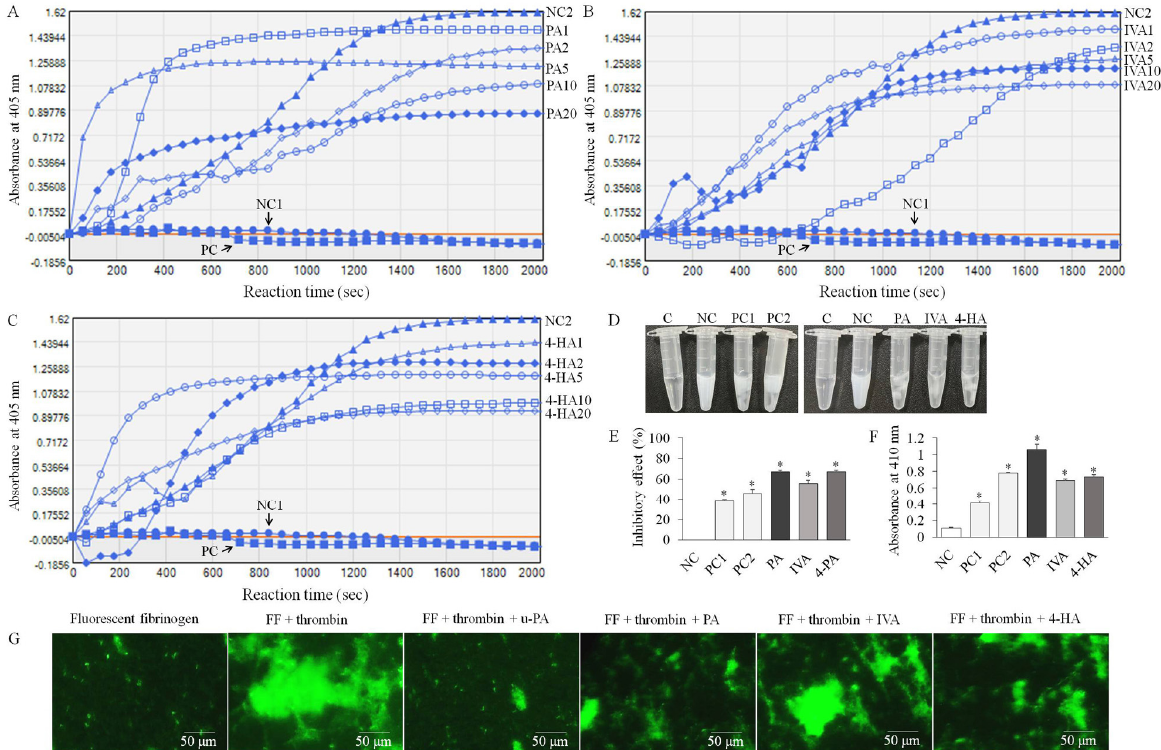
Figure 2. In vitro antithrombotic effects of PA, IVA, and 4-HA. ( A – C ) Turbidity assay. ( D , E ) Fibrin clot assay. ( F ) In vitro antithrombotic activity assay using blood clot. ( G ) Fibrin clot assay using a fluorescence microscope. Each value is the mean ± SD of triplicate measurements. * p < 0.01, compared to the non-treated control (NC) group. NC1, fibrinogen only; NC2, fibrinogen treated with thrombin; PC, positive control group (10 IU u-PA); PA1–20, 1–20 μg of PA treated; IVA1–20, 1–20 μg of IVA treated; 4-HA1–20, 1–20 μg of 4-HA treated; PC1–2, 10–20 IU u-PA; FF, fluorescent fibrinogen. 2.3. PA, IVA, and 4-HA Decrease the Enzymatic Activities of Procoagulant Proteinases The activity of thrombin was significantly decreased ( p < 0.01) by PA, IVA, or 4-HA at the highest concentration of each compound ( Figure 3 A). Likewise, significant reductions ( p < 0.05) were confirmed in the PA-, IVA-, or 4-HA-treated activated factor X (FXa) or activated factor XIII (FXIIIa) groups compared to the control group without any compound treatment ( Figure 3 B,C).